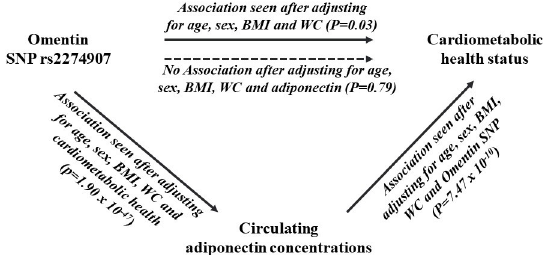
Fig 3. Diagram showing the role of circulating adiponectin as an intermediate predictor between omentin SNP and cardiometabolic health status. One-sided arrows with unbroken lines represent significant associations and one- sided arrows with broken lines represent lack of associations. There is a significant association between the omentin SNP rs2274907 and lower serum adiponectin concentrations after adjusting for age, sex, BMI, WC and cardiometabolic health status (p = 1.90 x 10 − 47 ). There is a significant association between serum adiponectin concentrations and cardiometabolic health status after adjusting for age, sex, BMI, WC and SNP rs2274907 (p = 7.47x10 -10 ). There is no association between the omentin SNP rs2274907 and cardiometabolic health status after adjusting for age, sex, BMI, WC and serum adiponectin concentrations (p = 0.79). Abbreviations: BMI, Body mass index; WC, waist circumference; SNP, Single nucleotide